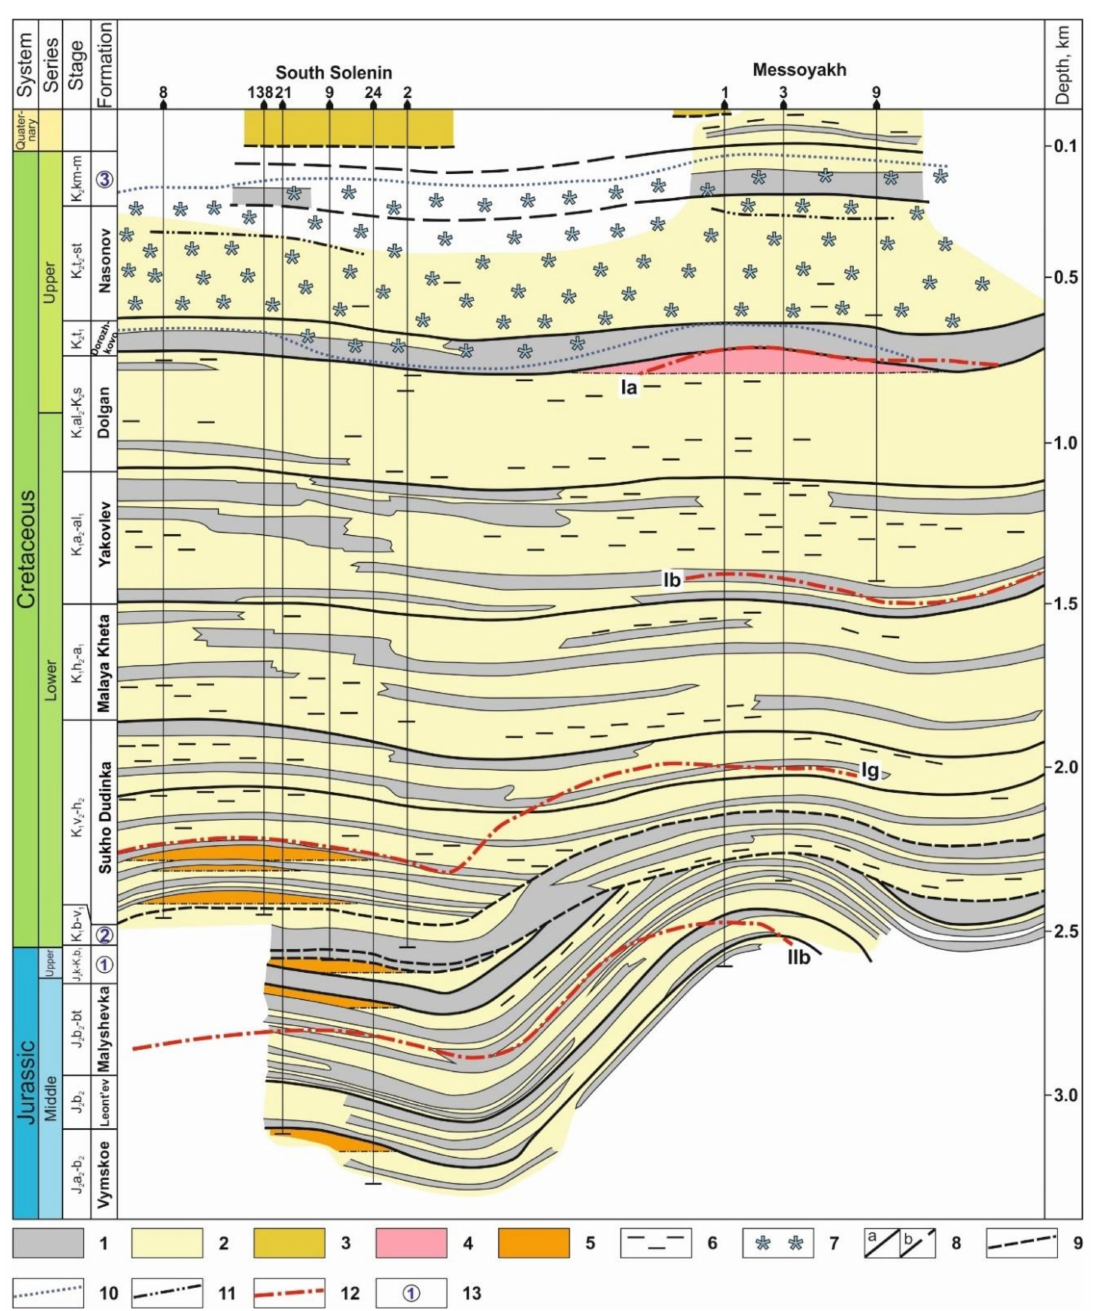
Figure 14. Geological section across the South Solenin and Messoyakh fields from Reference [90]